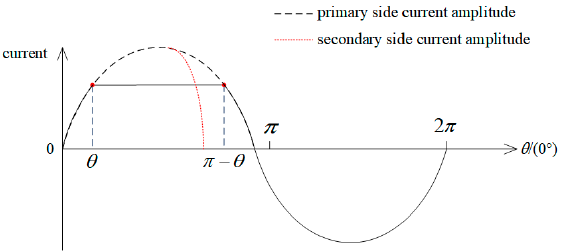
Figure 4. Current waveform after transient saturation of current transformer.